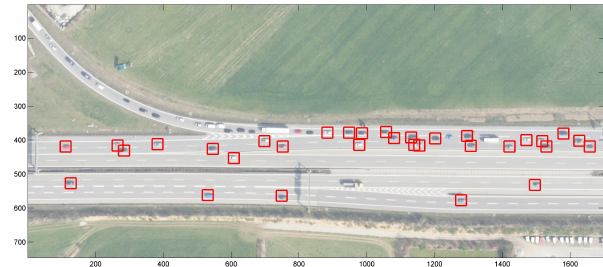
Figure 10: Classification result with motion mask